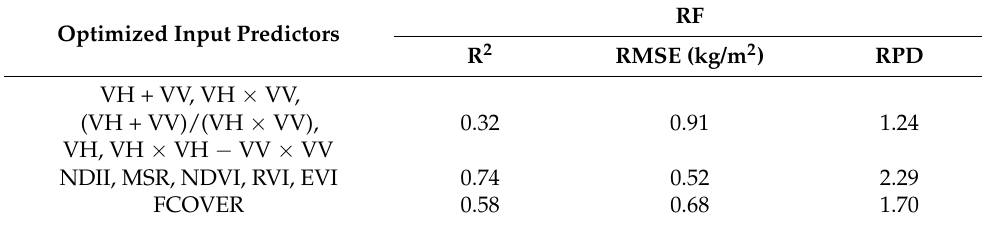
Table 7. Performance of the optimized RF models on estimating maize